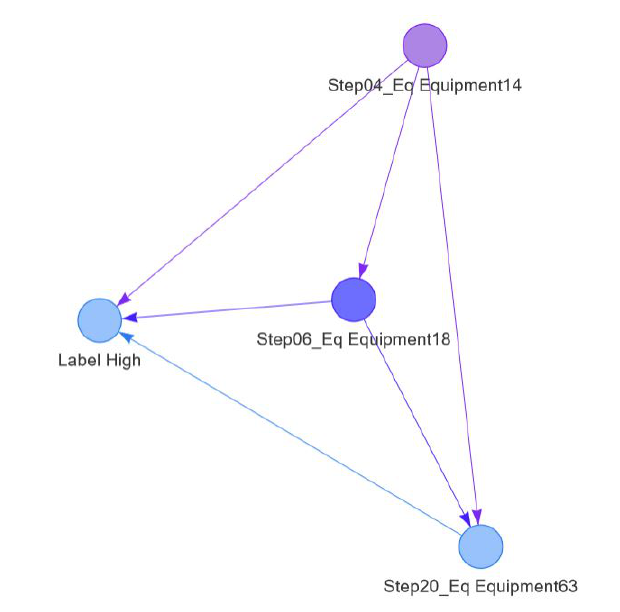
Figure 3. Detail of an example of visualization of PMI overlap among different tuples in simu- lated